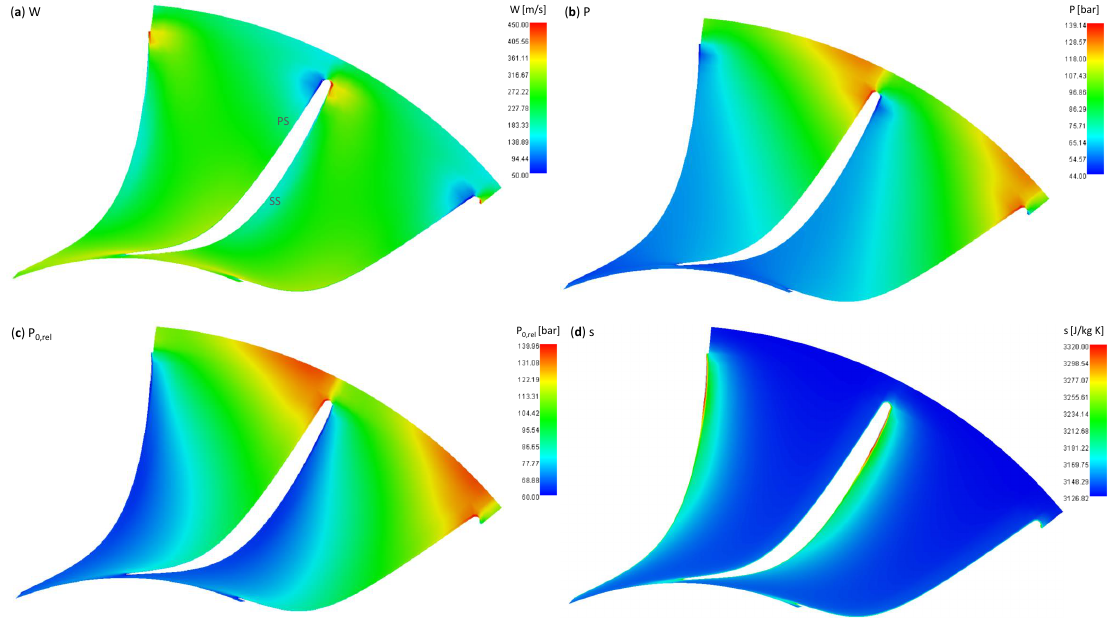
Figure 13. Mid-span parameters distribution for isolated rotor 3D CFD